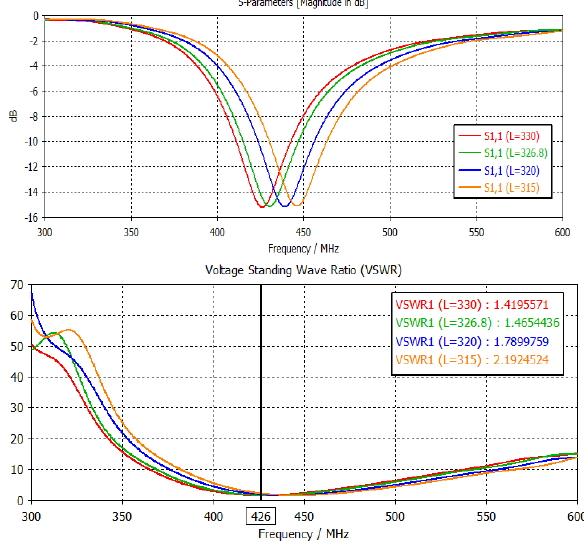
Figure 9. Masat-1 half-wave dipole integrated with the cubic structure in